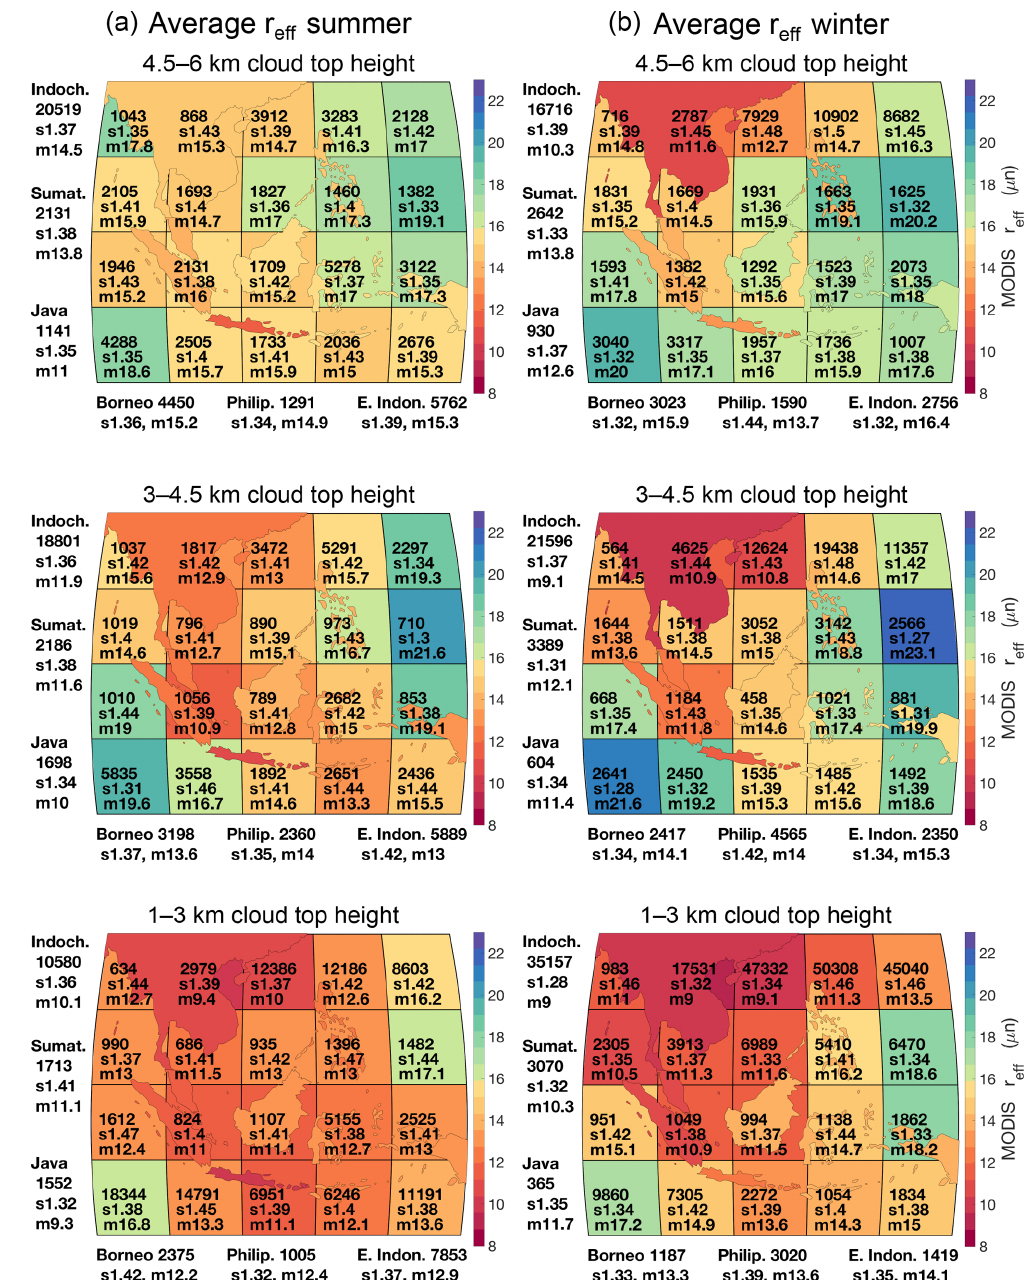
Figure 7. Geometric means of baseline r eff for each ocean grid and land region for summer (a) and winter (b) spanning 2006 to 2016 for three cloud height regimes. Each region is accompanied by three black bolded numbers; the first shows the number of counts in each r eff population, the second is the geometric standard deviation of each population (preceded by an “s”), and the third value is the median of the r eff population (preceded by an “m”). Bottom panels show clouds with tops at 1–3km in height, middle panels show clouds at 3–4.5km, and top panels show clouds at 4.5–6km. The color scale is the geometric mean of the effective radius (in microns).